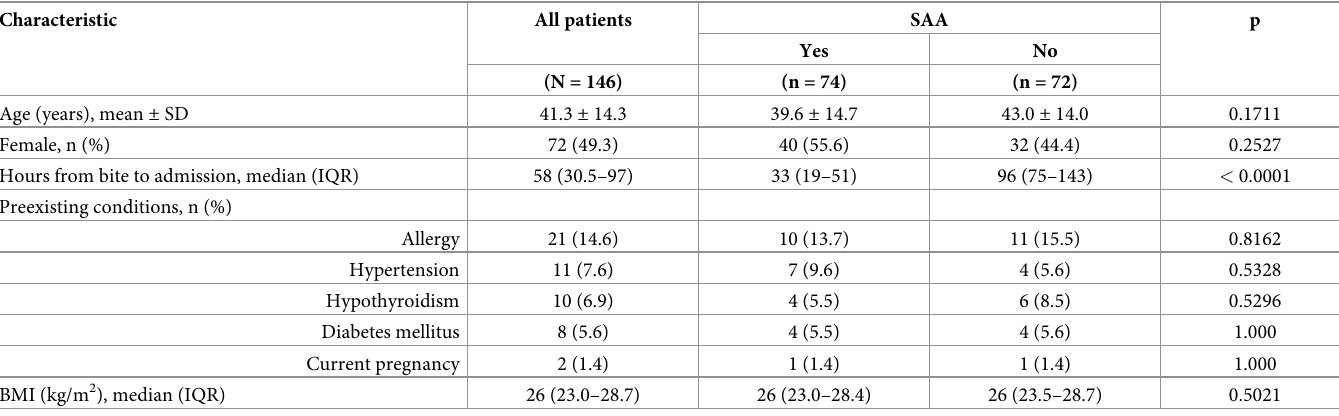
Table 1. Baseline characteristics of patients with loxoscelism.